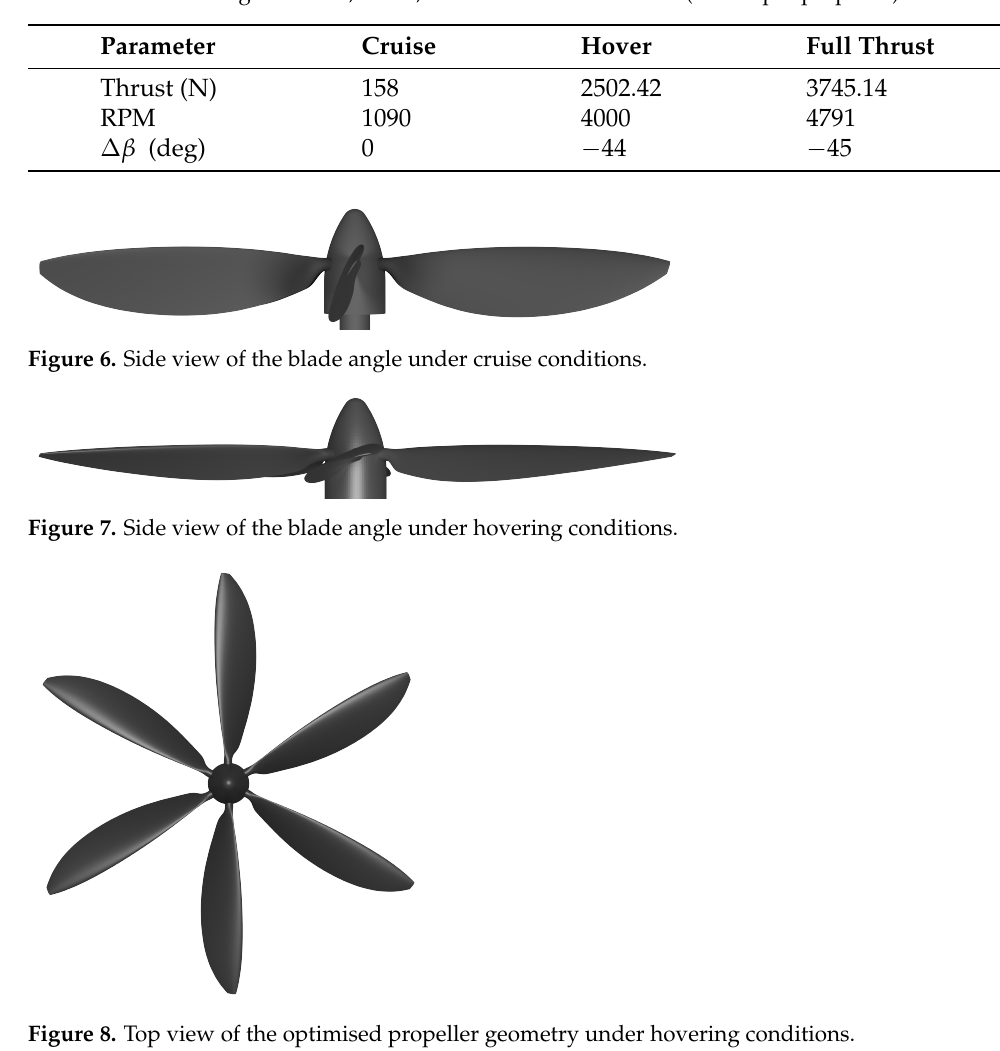
Table 1. Thrust settings at cruise, hover, and full thrust conditions (values per propeller).